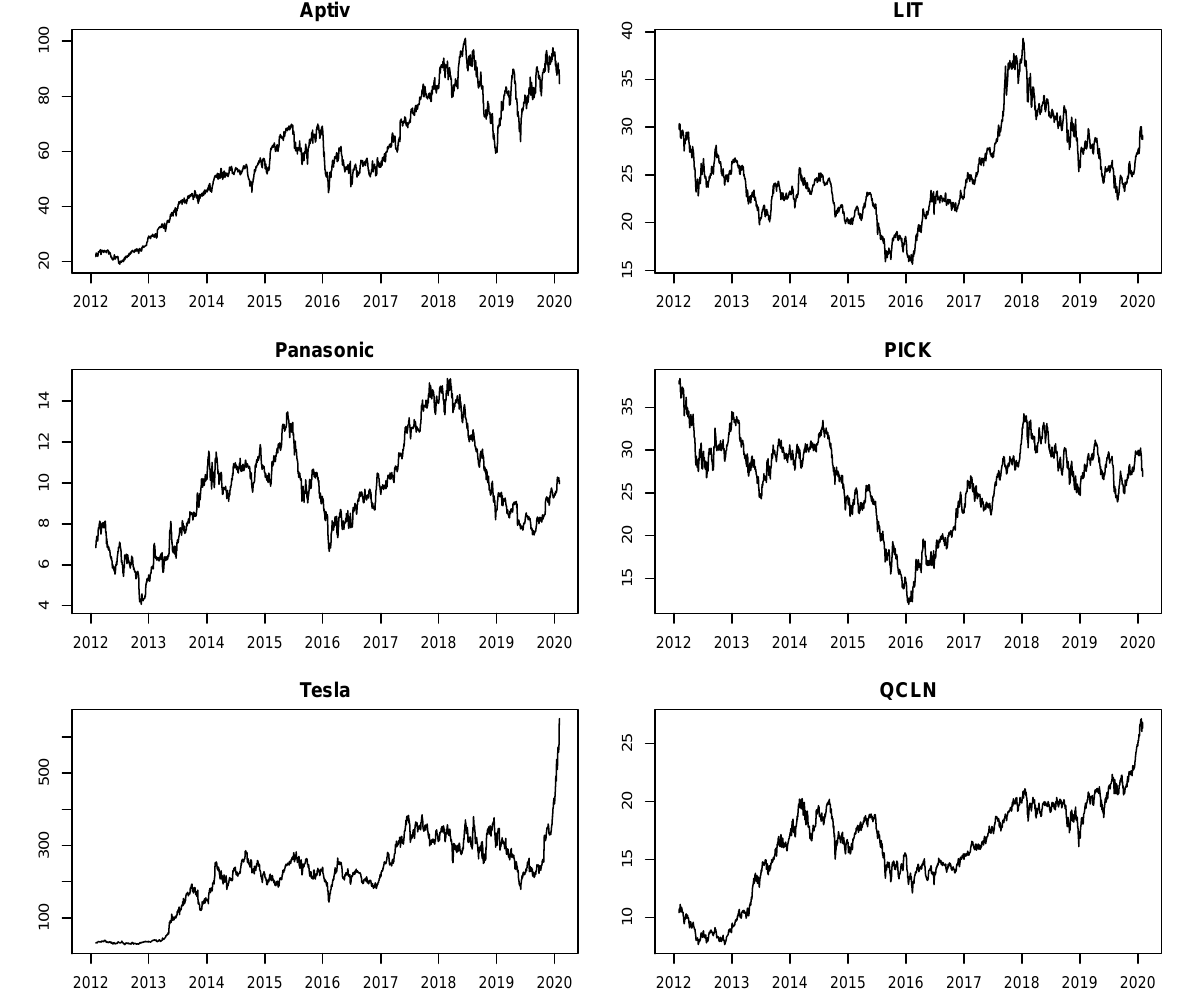
Figure 1. Asset prices in U.S. dollars; daily data from 2 February 2012 to 31 January 2020. Our sample contains daily data from 2 February 2012 to 31 January 2020, a total of 2011 observations. The start of the sample period is determined by data availability and the commercialization of mass production of electric cars. The end is selected to exclude the COVID-19 pandemic that was just starting at the time of data collection. Logarithmic price returns (abbreviated to returns and denoted by r t ) are computed as r t = ln ( P t / P t − 1 ) , where P t and P t − 1 are current and lagged daily prices, respectively. Table 1 provides descriptive statistics for the six logarithmic return